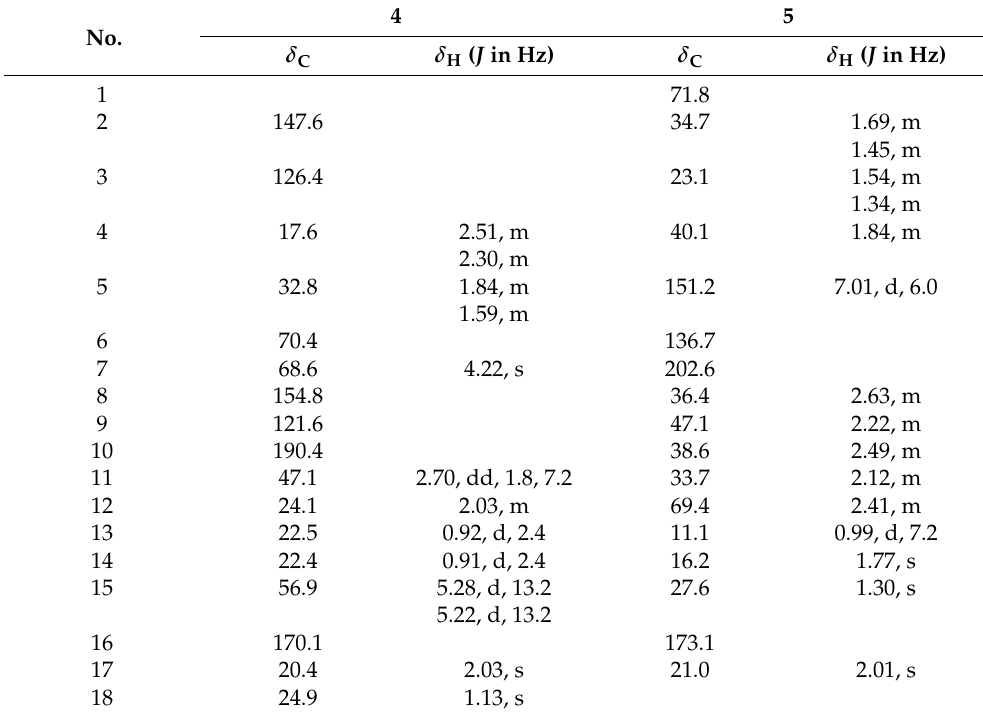
Table 2. 1 H (600 MHz) and 13 C-NMR (150 MHz) assignments of 4 (DMSO- d 6 ) and 5 (CD 3 OD).